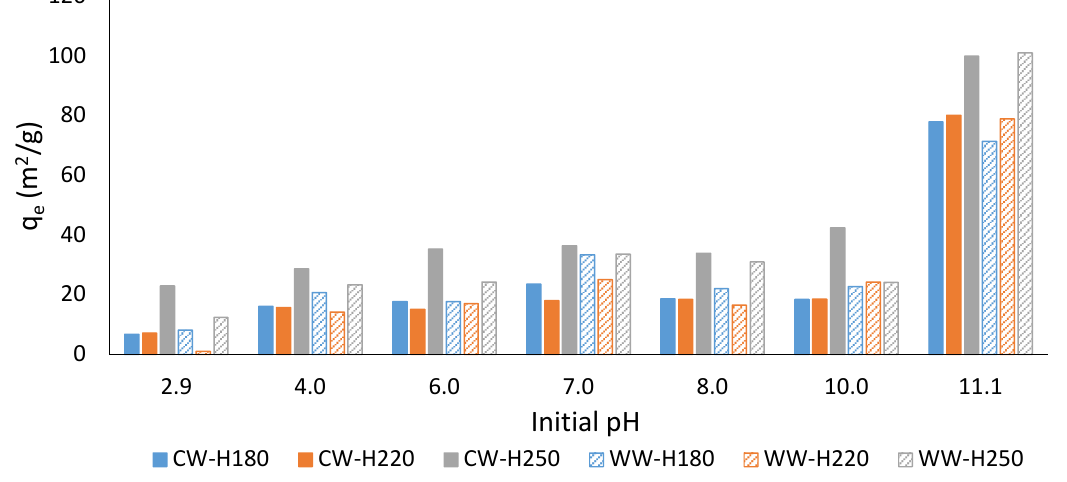
Figure 4. Effect of solution’s pH on dye adsorption by hydrochars produced from citrus and winery wastes.